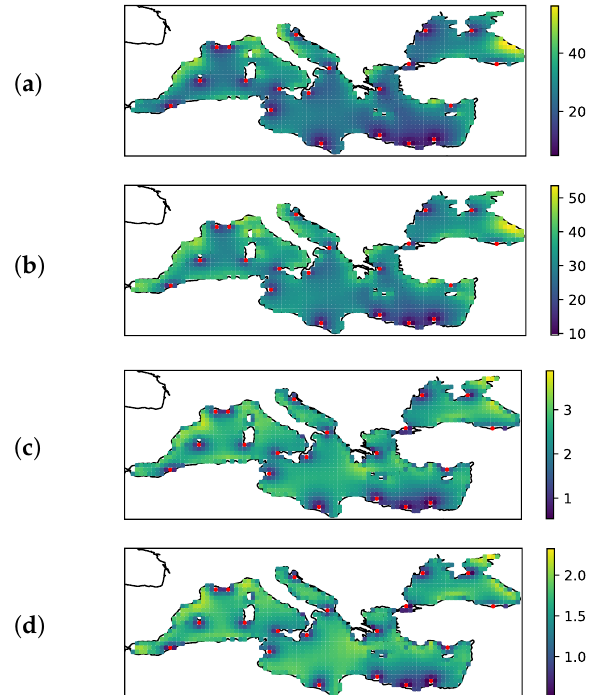
Figure 5. From ( a – d ): spatial distribution of the error for the selection of 20 sensor location using the K-means algorithm and distance to shore as an additional criterion. ( a ) α , ( b ) σ α , ( c ) A , ( d ) σ A ; ( a , b ) are in degrees, ( c , d ) are in m/s. The red dots denote the optimal sensor location selected by this